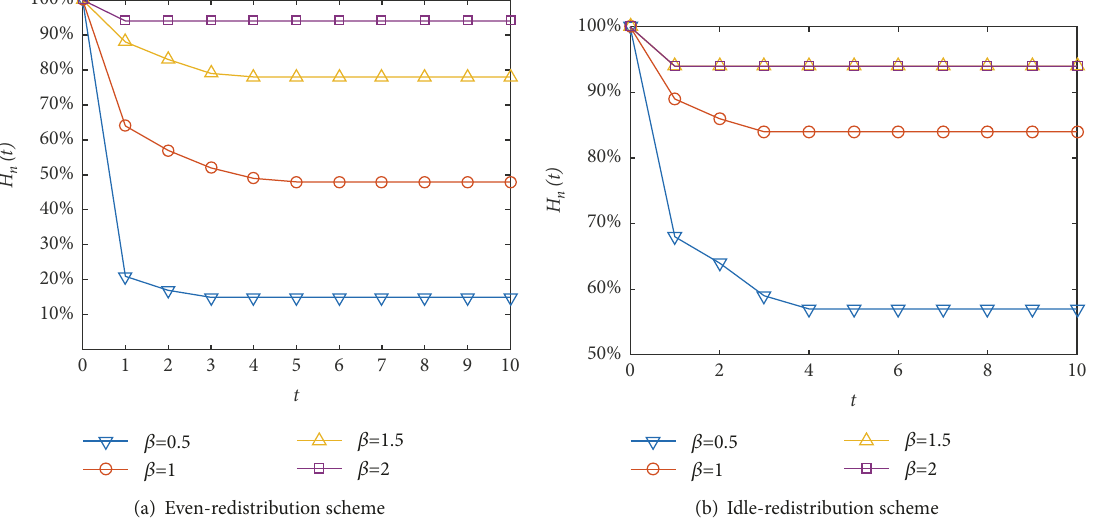
Figure 8: Survival ratio with varying 𝛽 ( 𝛼 = 1 , Δ𝑡 = ∞